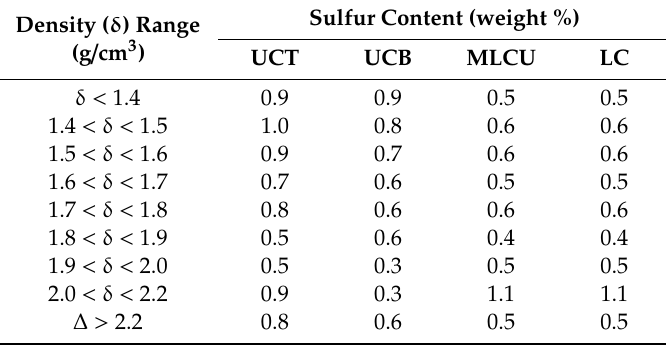
Table 2. Total sulfur content (wt%) in di ff erent density ranges for the UCT, UCB, MLCU, and LC coal